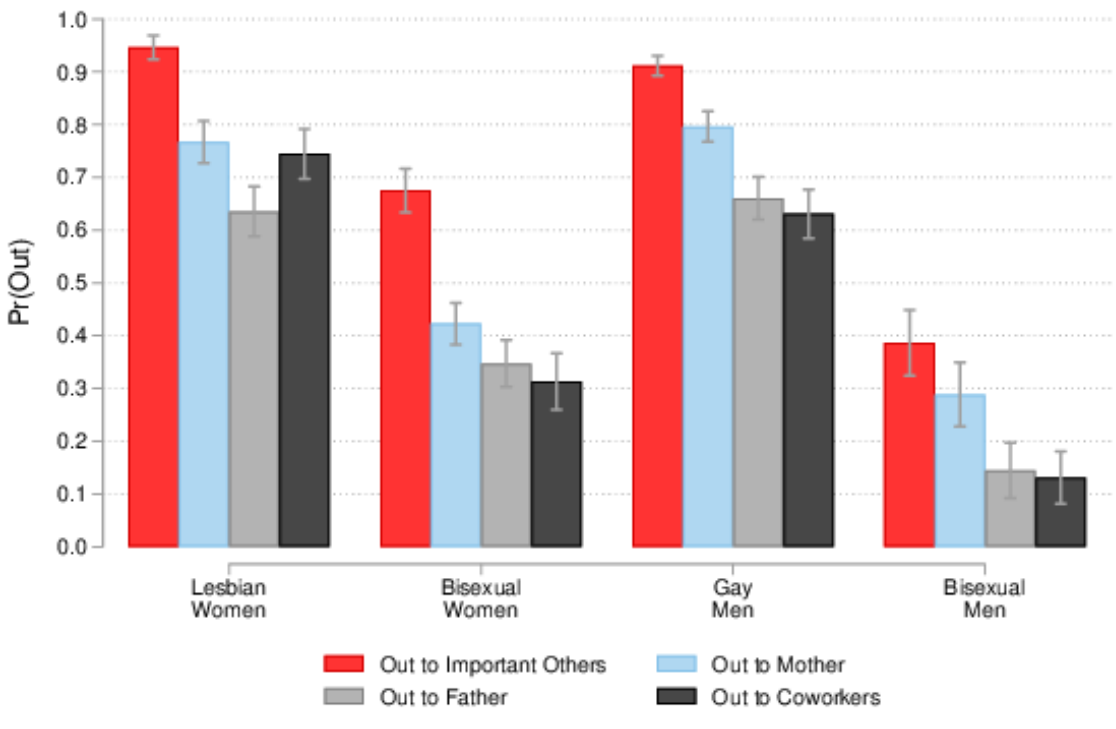
Figure 1: Predicted probability of sexual identity disclosure by group, across domains. Note: Error bars represent ± 1 standard error of the